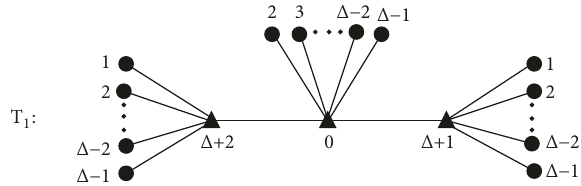
Figure 4: Irreducible 𝐿(2, 1) -span coloring of 𝑇 1 with one hole.